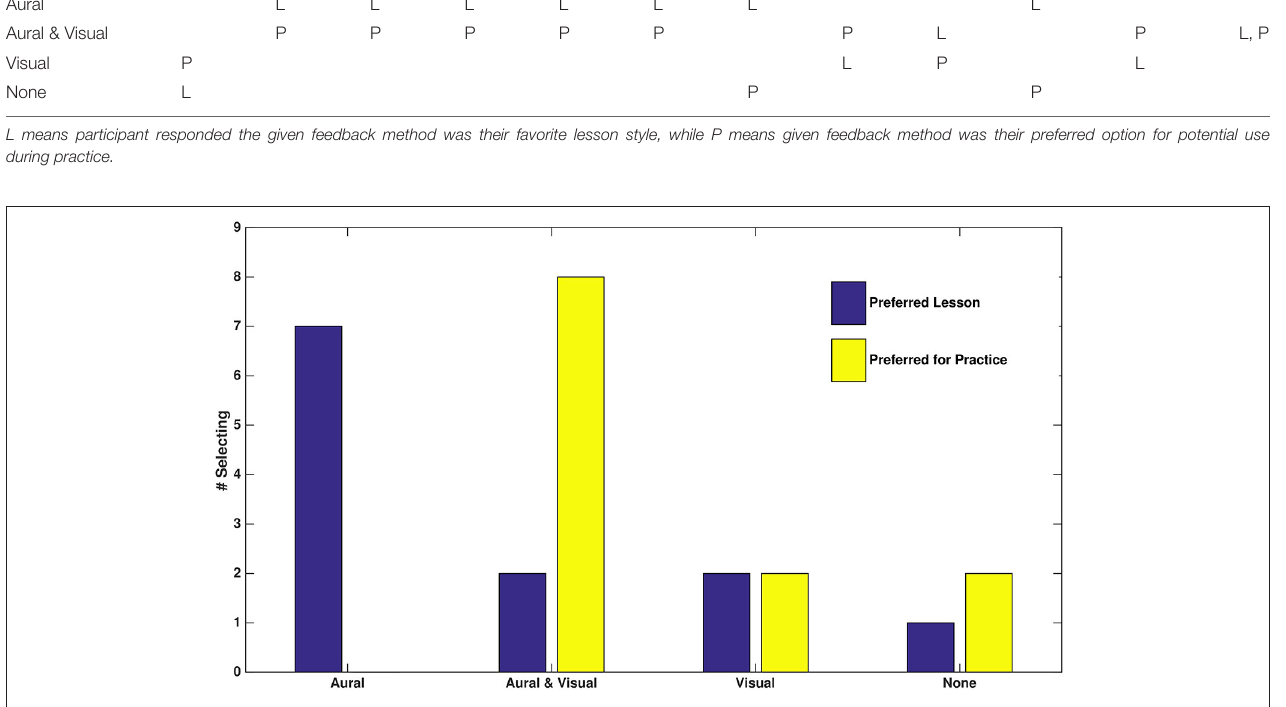
FIGURE 4 | Reported preferences of the 12 participants for favorite lesson within feedback types and what feedback option(s) would be most helpful during